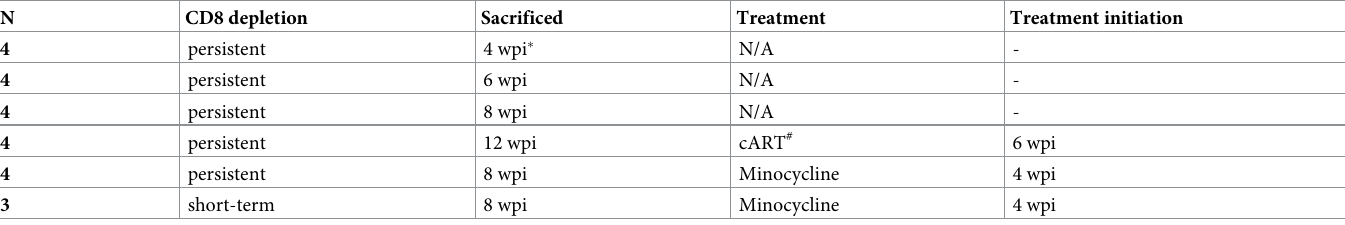
Table 1. Cohorts of SIV-infected